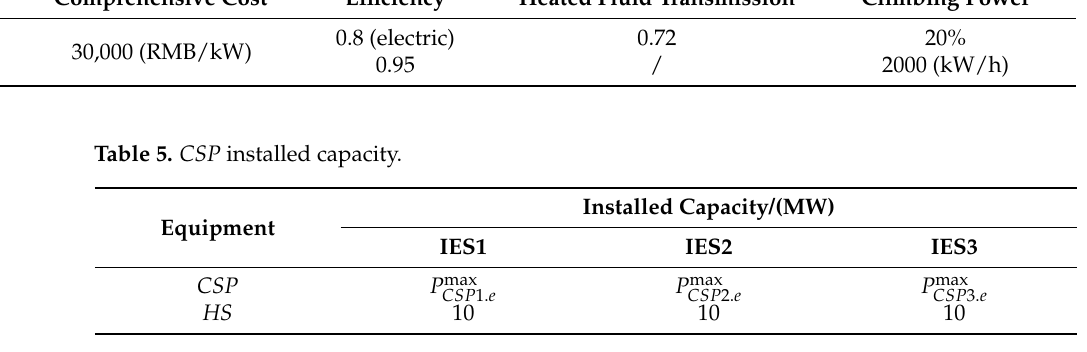
As indicated in Table 5, P max generation stations of IES, IES2, and IES3, respectively.